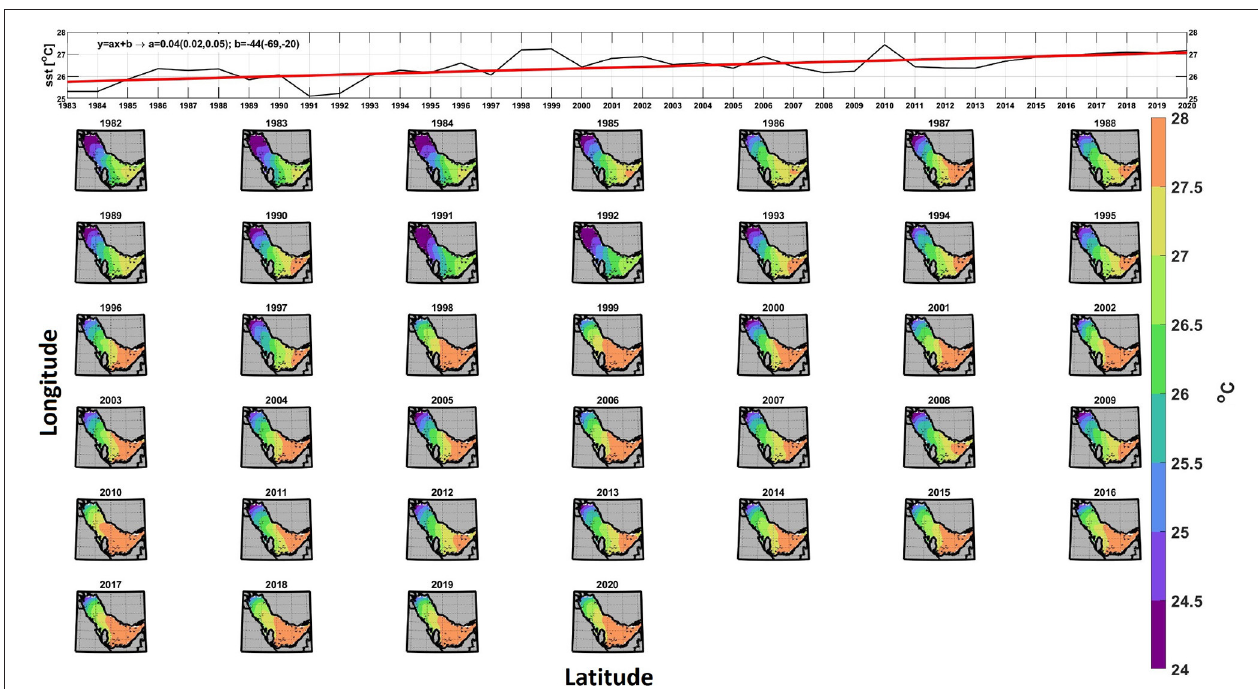
FIGURE 7 | (Top): Time series of yearly averaged SST anomalies for years 1982–2020; (Bottom map) yearly averaged SST anomaly Gulf maps. SST: sea surface temperature.